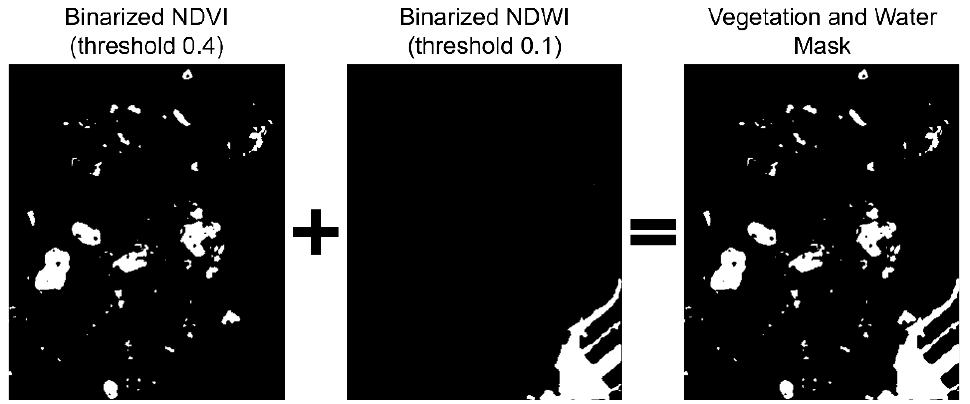
Figure 3. Combining binarized NDVI and NDWI to create vegetation and water mask.